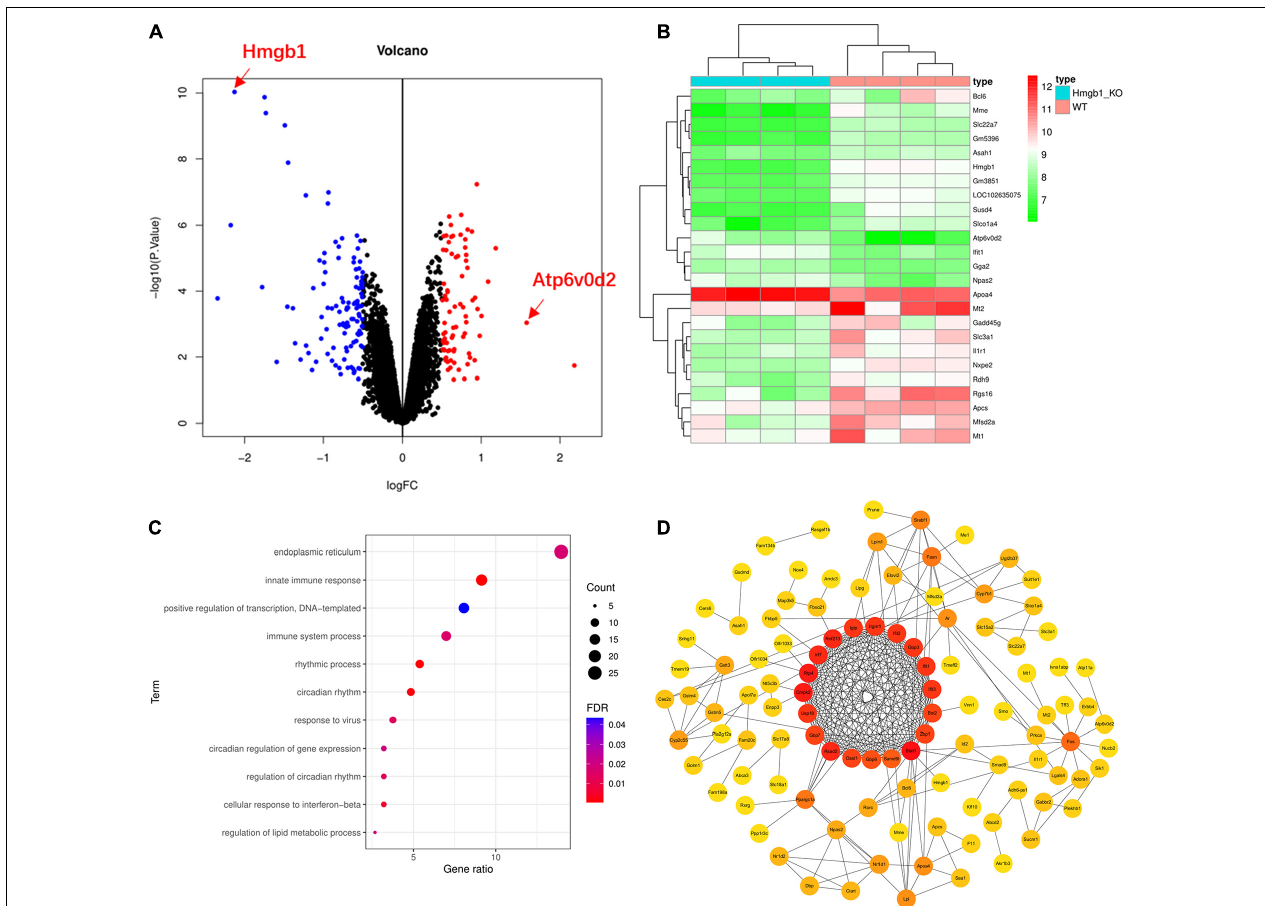
FIGURE 4 | Genes and pathways showed significant changes in Hmgb1 − / − mice compared to controls. (A) Our in silico re-analysis of microarray data from Hmgb1 − / − and controls showed 82 upregulated genes and 112 downregulated genes including Atp6v0d2. (B) A heatmap showing the comparison of the differentially expressed genes (DEGs) among the Hmgb1 − / − and control mice. (C) Multiple immune pathways in response to viral infection are enriched in DEGs. (D) The protein–protein interaction (PPI) network formed by DEGs.